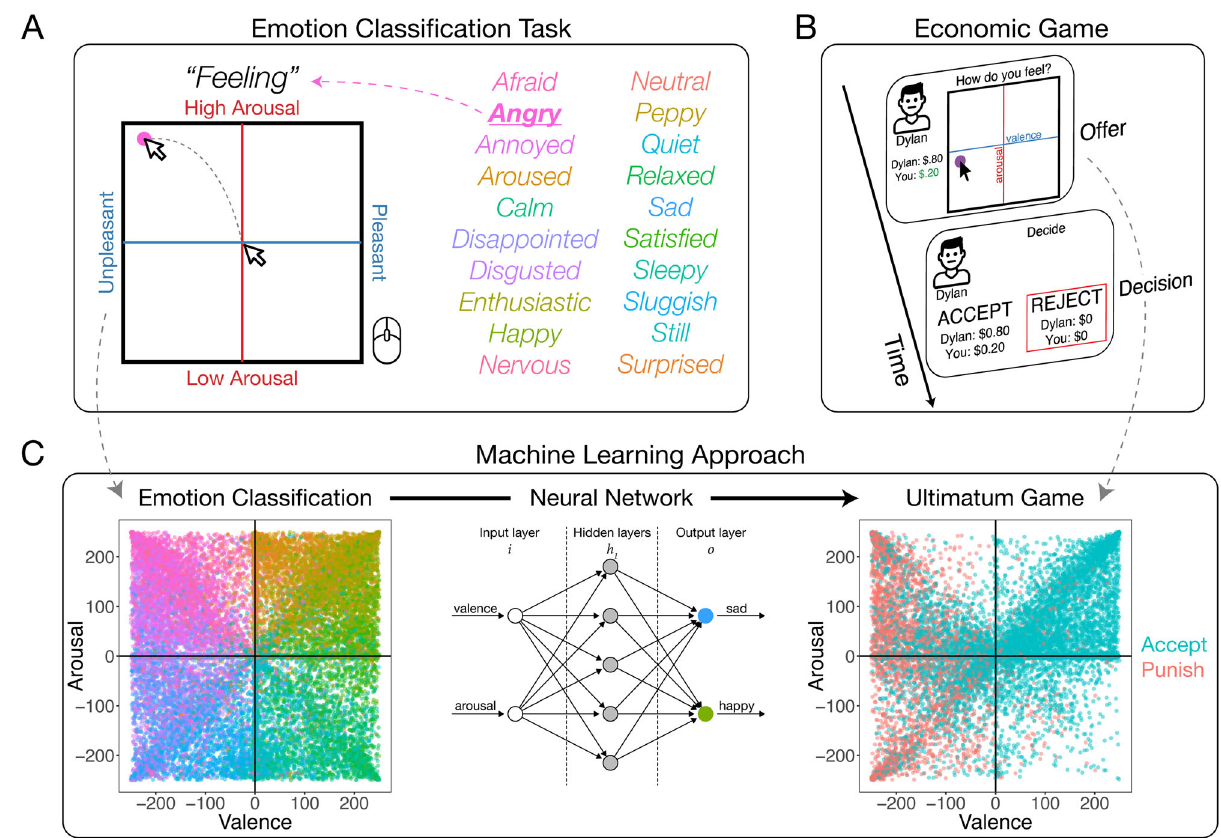
Fig. 1 Task design. A Emotion classi fi cation task schematic. Participants rated a variety of feeling labels using the arousal (vertical) and valence (horizontal) axes on a 500 × 500 pixel grid. The feeling labels for the emotion classi fi cation task are listed. B Economic game schematic. In a second task, participants played as the second mover in a dyad or group setting, deciding whether to punish a norm transgressor (UG) or defect in a cooperation game with one (PD) or three (PGG) partners. Here we provide a schematic of Experiment 1: The Ultimatum Game. Participants are paired with a partner, receive an offer, rate how they felt about that offer, and choose to accept or reject the offer. C Machine learning approach. Emotion classi fi cation ratings (colors correspond to emotion classi fi cation task words) were used to train a feed-forward neural network, shown in a simpli fi ed schematic predicting two emotion classes (see Methods). After cross-validation, the trained neutral network was applied to the unlabeled emotion experiences in the Ultimatum Game. Ultimatum Game data is color coded by the choice to accept (blue) or reject